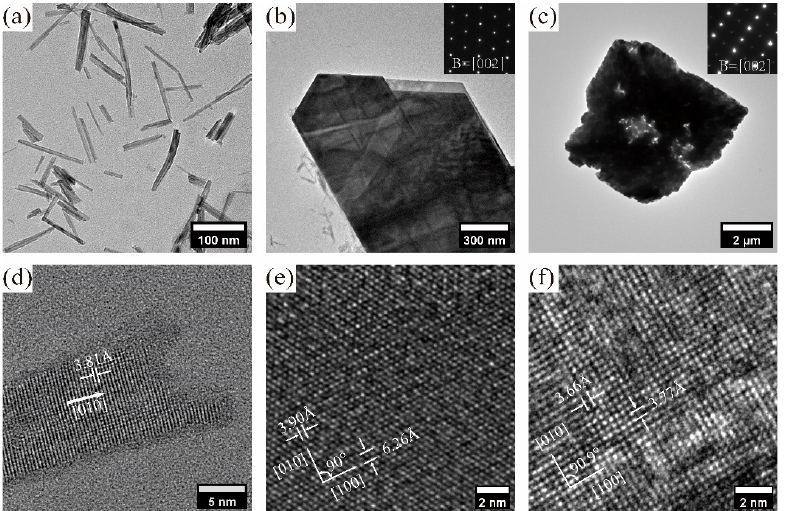
Figure 6. Low-magni fi cation TEM images of ( a ) W 18 O 49 (sample 1 and sample 6), ( b ) WO 3 ·0.33(H 2 O) (sample 2 and sample 3), and ( c ) γ -WO 3 (sample 5 and samples 7–10); high-resolution TEM images ( d ) W 18 O 49 (sample 1 and sample 6), ( e ) WO 3 ·0.33(H 2 O) (sample 2 and sample 3), and ( f ) γ -WO